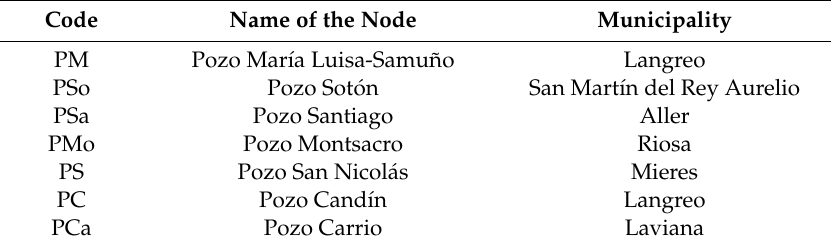
Table 1. Nodes defined in the Central Asturian Coal Basin (CACB) study area.